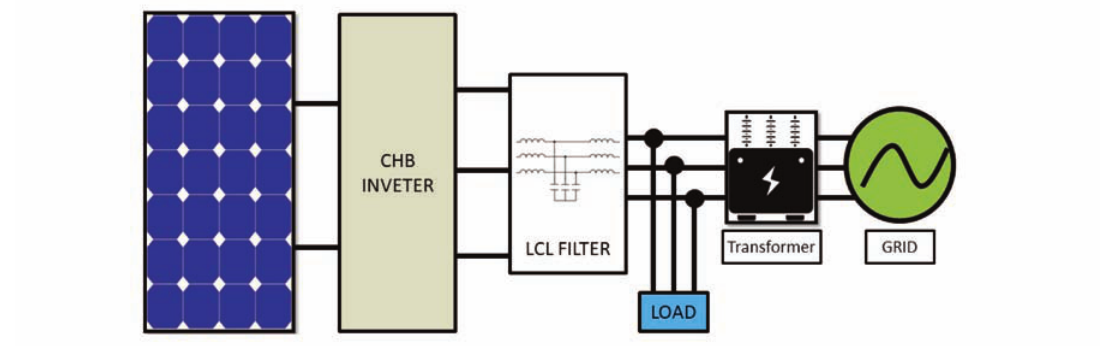
Fig. 6. PV grid-connected model developed in a computer simulation platform.